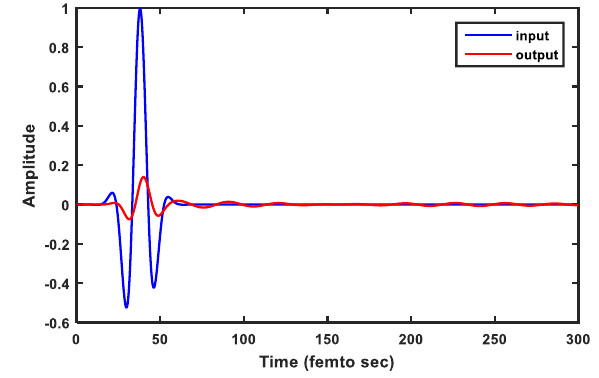
Fig. 5 Transient response of the Graphene nano patch antenna